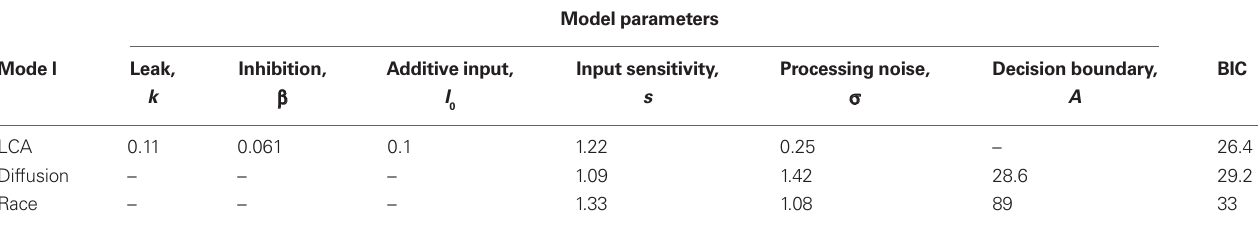
Table 3 | Model parameters to optimized fits (Figure 9).